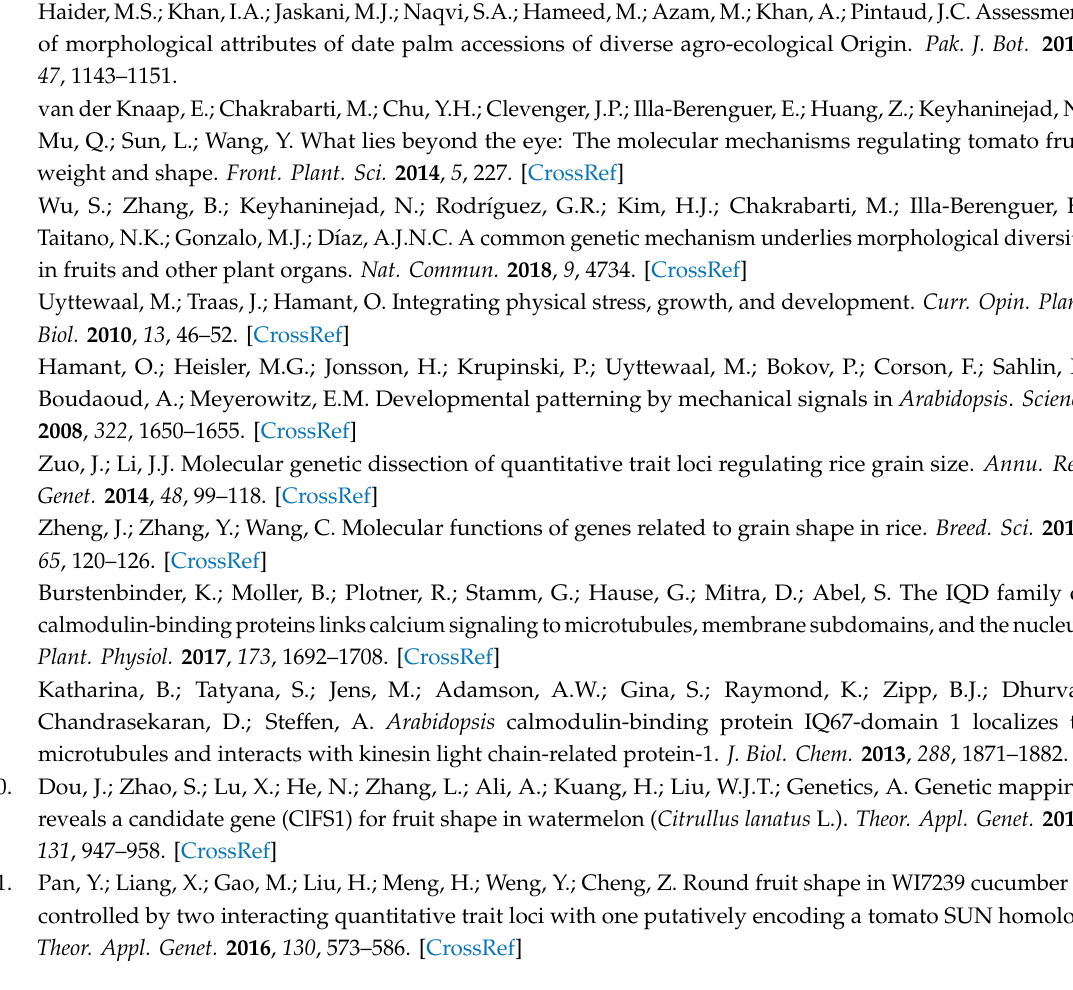
Figure S1. LOGOS representation of the conserved motifs (1–10). Figure S2. Transcriptional profiling of 49 VvIQDs in grapevine berries during di ff erent developmental stages. Figure S3. Transcriptional profiling of 49 VvIQDs in organ and / or tissue development of grapevine. Figure S4. The principal component analysis (A and B) of various organs used in our study. Figure S5. Geno ontology (GO) based enrichment analysis of VvIQDs in the grapevine genome. Figure S6. Kyoto encyclopedia of gene and genome (KEGG) analysis of VvIQDs in the grapevine genome. Figure S7. Promoter analysis of VvIQDs in the grapevine genome. Table S1. List of the primers used for the qRT-PCR analysis. Table S2. Biochemical properties, including protein length, chromosomal position, isoelectric point (pI), molecular weight (MW), and subcellular prediction of VvIQD genes. Table S3. Ka / Ks values of the homolog and ortholog gene pairs compared with Arabidopsis . Table S4. The transcriptional profile of 54 di ff erent organs. Table S5. The Principal Component Analysis of RT-PCR